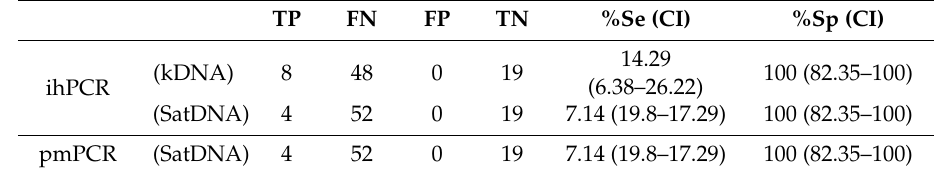
Table 3. Performance of the two PCR assays for the detection of T. cruzi DNA when compared to the known Chagas disease (positive to at least two serological tests) diagnosis in 75 blood samples. TP